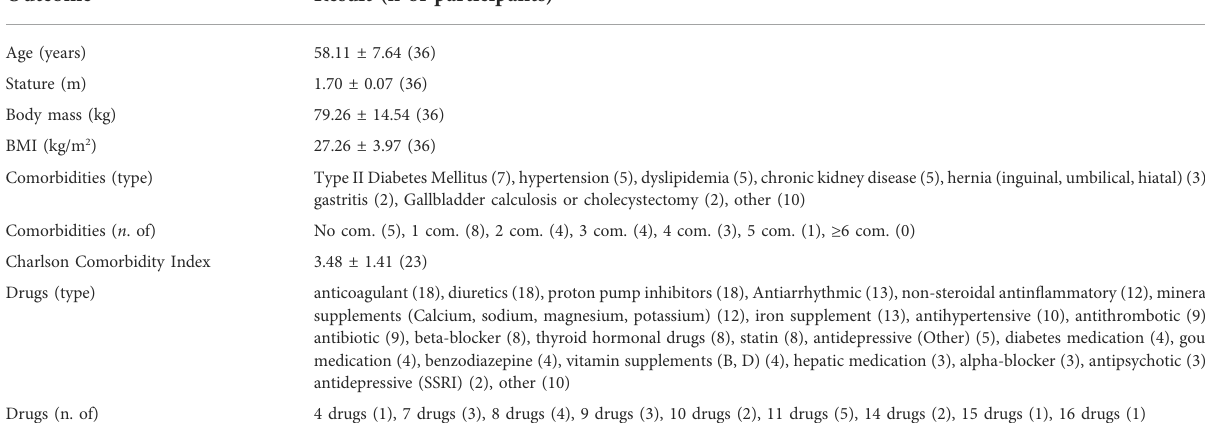
oscillations were 41.77 ± 12.90 mm. In the dual task sway area was 53.24 ± 28.68 mm 2 /s, mean anterior-posterior oscillations were 26.63 ± 9.67 mm, and mean lateral oscillations were 31.80 ± 8.79 mm.